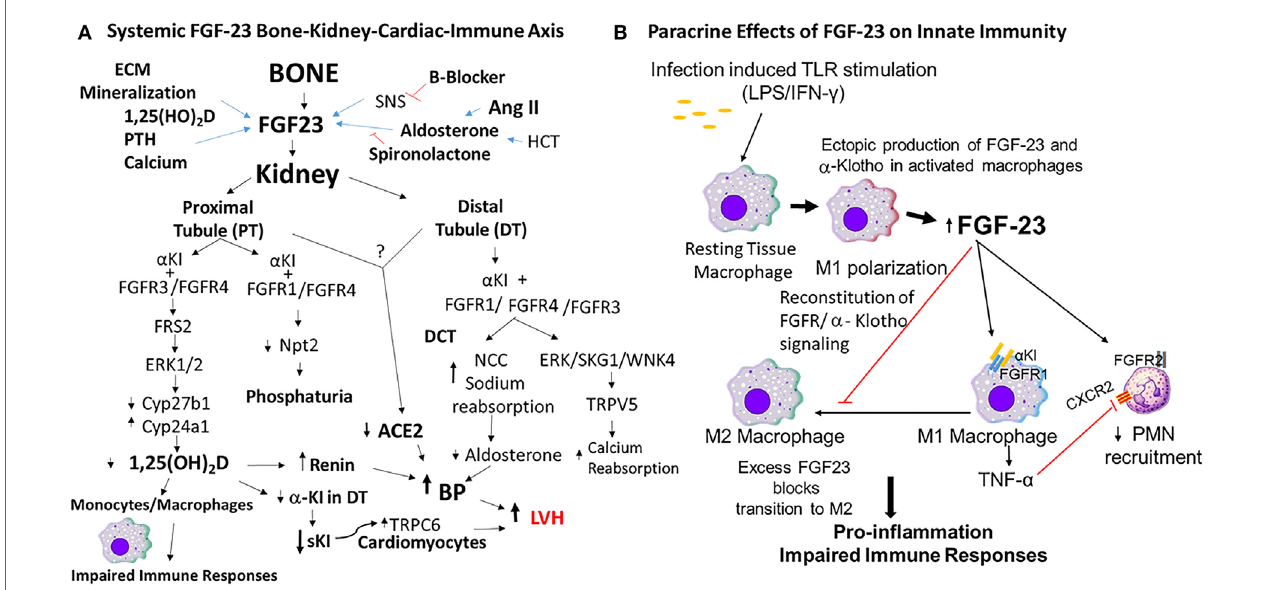
FiGuRe 1 | Mechanisms of fibroblast growth factor-23 (FGF-23) effects to impair innate immune responses. (A) FGF-23 bone–kidney–cardiac–immune axis. FGF-23 is produced by osteoblasts/osteocytes in bone in response to local and systemic factors and targets the kidney to create multiple endocrine networks (4, 13) in bone, including (1) an FGF-23 vitamin D counter-regulatory loop (4, 14); (2) a calcium-FGF-23 endocrine loop, where calcium stimulates FGF-23 in bone and FGF-23 stimulates calcium reabsorption in the DT (15, 16); (3) a bone–kidney axis, where FGF-23 is regulated by factors involved in extracellular matrix mineralization to coordinate renal phosphate handling (1). In addition, there is a bone–renal–cardiac axis that augments hemodynamic responses through a feed forward bone–cardio–renal loop, where angiotensin II (Ang II) stimulates FGF-23 production in bone (17) and FGF-23 suppresses Ace2 in the kidney (18), a volume regulatory loop where diuretics and aldosterone stimulate FGF-23 production by bone and FGF-23 targets the distal tubule to increase sodium reabsorption, and a FGF-23 soluble Klotho (sKl) regulatory axis, where FGF-23 suppresses α -Kl expression in the distal tubule leading to reduction in sKl and loss of the hormonal effects of this antiaging hormone. In this schema, FGF-23 regulates innate immune response through suppression of 1,25(OH)D2 production by the kidney. (B) Paracrine effects of FGF-23 on innate immune responses. Macrophages do not normally express FGF-23 or α -Klotho, but in the setting of infection, LPS/IFN γ induces the ectopic expression of both FGF-23 and its co-receptor α -Klotho that reconstitutes paracrine FGF-23 signaling in macrophages. FGF-23 stimulates pro-inflammatory responses in M1 macrophages and blocks the transition to M2 macrophages (3). In addition, FGF-23 is proposed to directly activate FGFR2 in PMNs to decrease recruitment